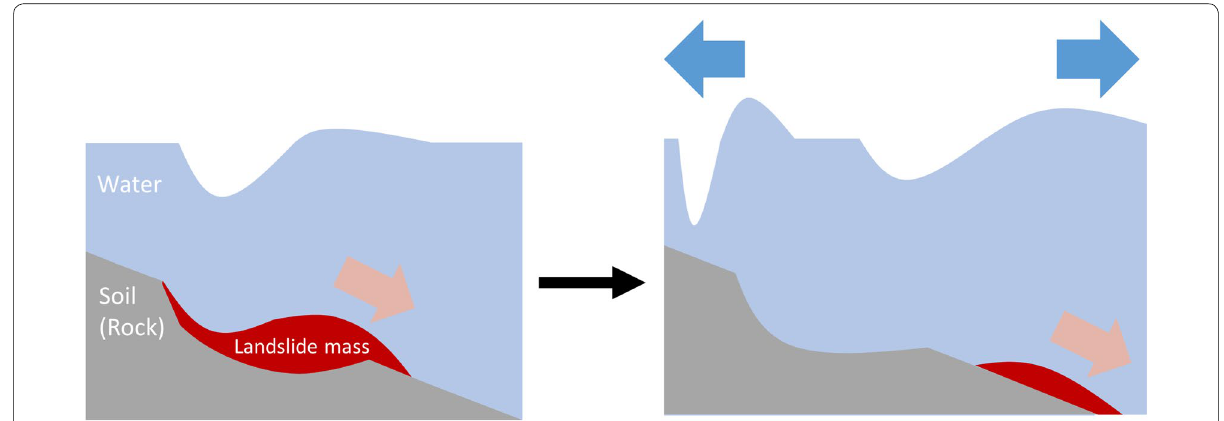
Fig. 2 Conceptual diagram of tsunami